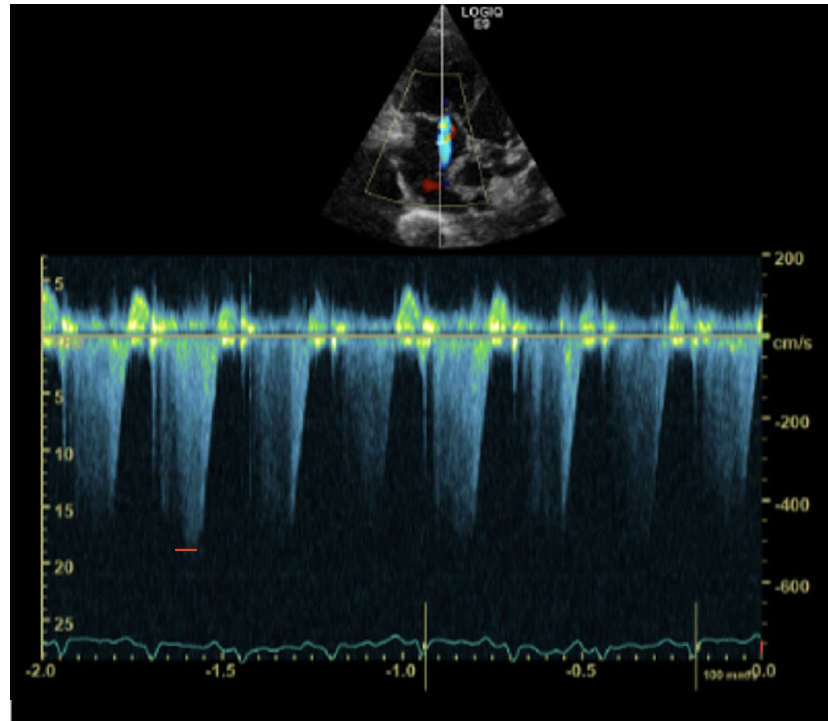
Figure 3. Transthoracic left apical window modified 4–chamber optimized for the right heart. Doppler imaging shows a tricuspid regurgitation with a peak blood flow velocity of 5 m/s (red stripe), representing an estimated RV pressure of at least 100 mmHg.